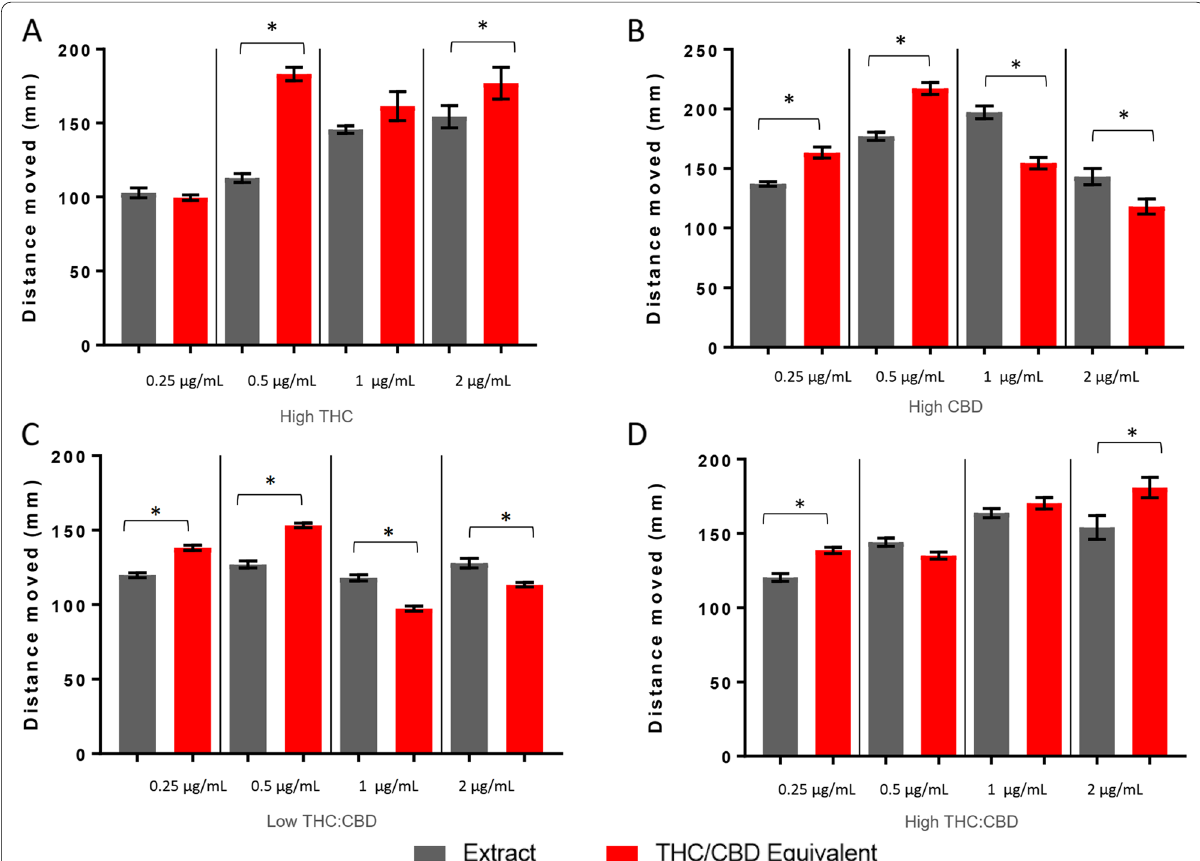
Fig. 3 Larval locomotion following exposure to high THC, high CBD, low‑temp THC:CBD, and high‑temp THC:CBD extracts. Larval behavioral profiles following exposure to the extract and molar equivalence of THC/CBD at varying concentrations. Average distance traveled error ( SEM ) is presented over the first 30 min of the light cycle. Each bar represents an n measured by ANOVA followed by a Bonferroni post hoc test ( p <